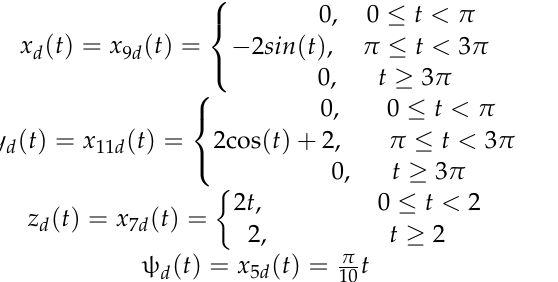
Figure 10. Control performance in the desired trajectory. Figure 11. Control performance in roll and pitch.